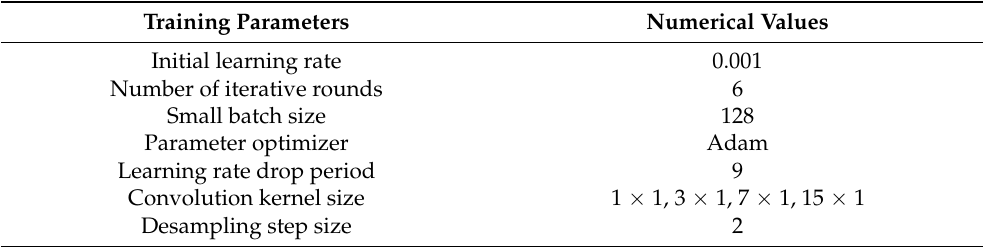
Table 2. Training parameters of